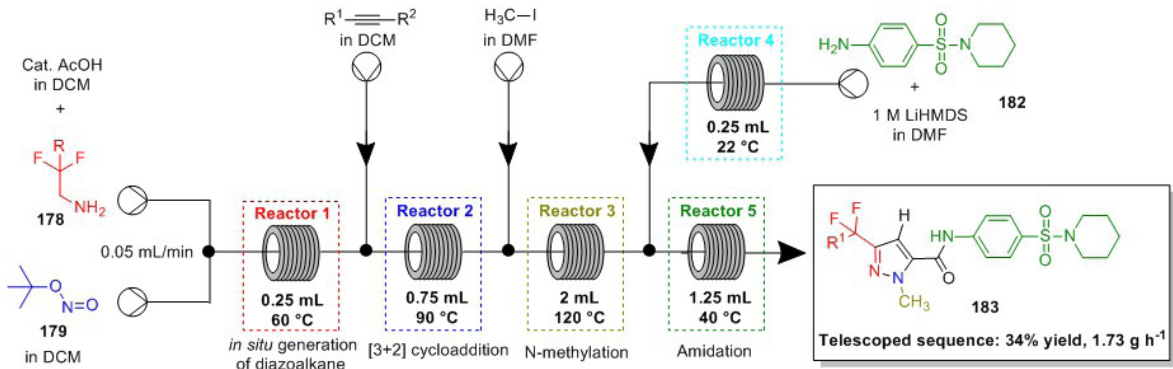
Scheme 42 - Synthesis of AS-136A using a unified continuous flow